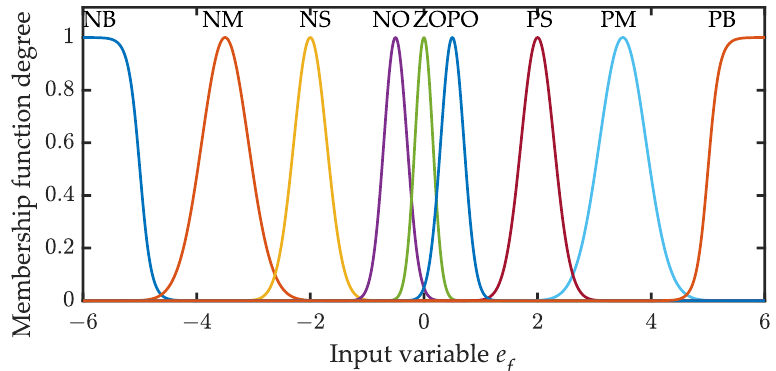
Figure 12. Membership function of input variable e f .